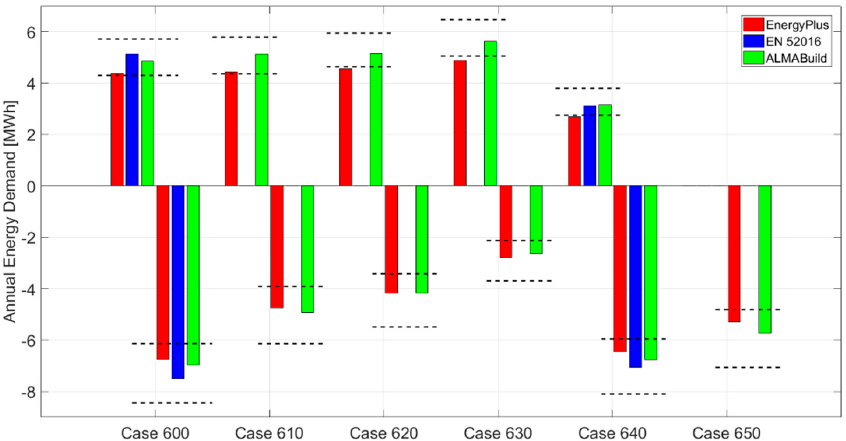
Figure 8. Comparison of the annual energy demand (MWh) predicted by EnergyPlus, the Standard EN 52016 and ALMABuild for lightweight BESTEST buildings.